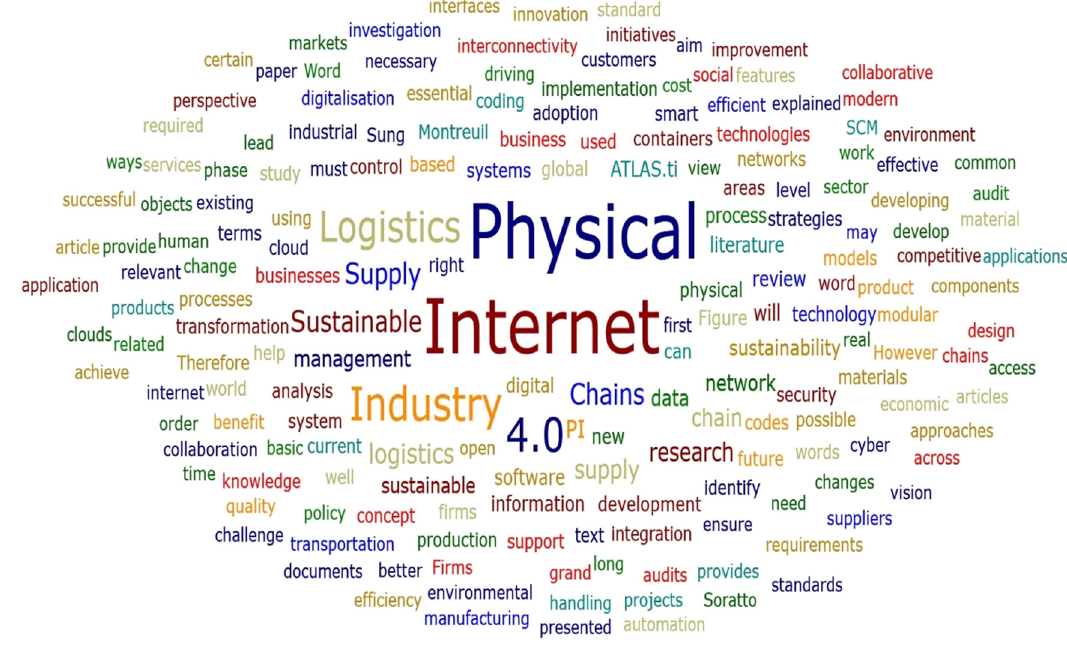
Figure 5: Word cloud information on